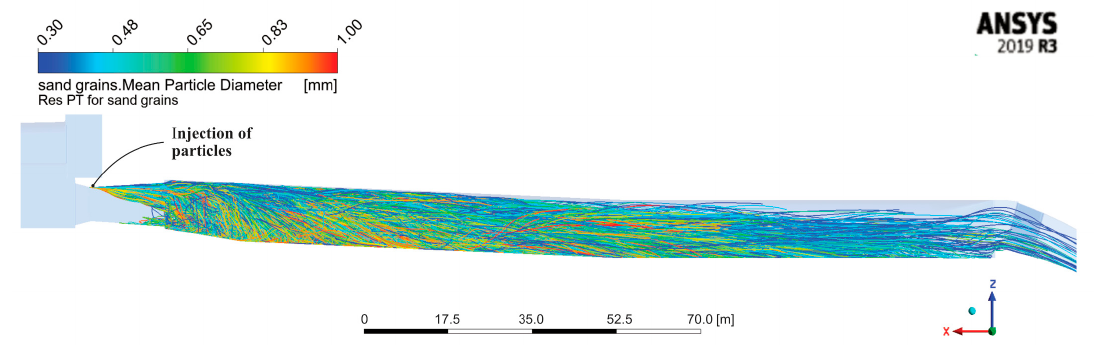
Figure 9. Snapshot from time-step 300 s (flow through factor 1.26 [–]) of simulation with 0.3–1.0 mm sand particles with one-way coupling (no collision of particles), scale 1:1, 80 m³/s discharge inflow velocity with upstream influence, 4000 particle tracks, side view.